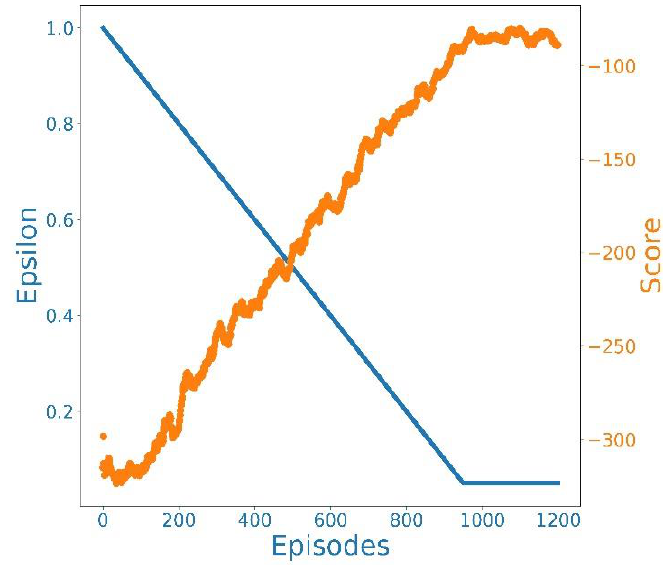
Figure 7. Convergence of the D3QN-based Scheme.